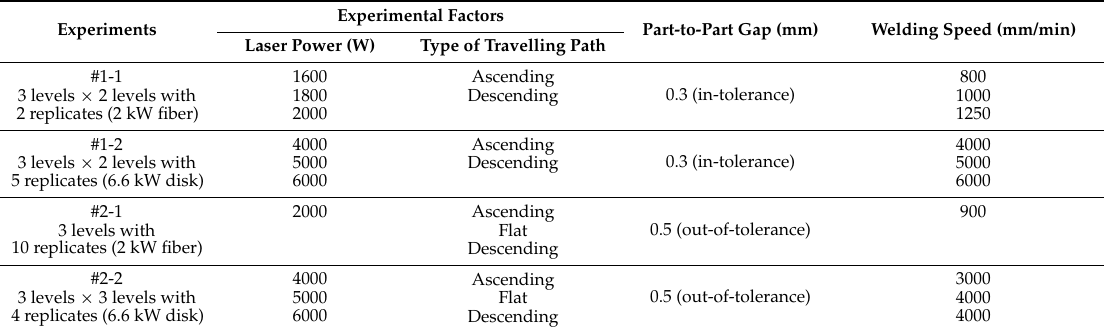
Table 5. Experimental design.